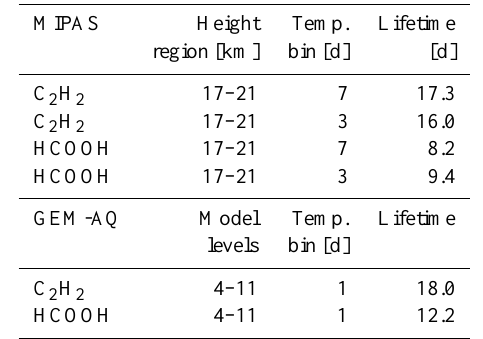
Table 3. Calculated e-folding lifetimes (in days) of measured (MI- PAS) and modelled (GEM-AQ) enhanced C 2 H 2 and HCOOH in the plume released by the Australian bushfires of February 2009. Model levels 4–11 approximately correspond to the height region 17–21km. “Temp. bin” is the length of subsequent periods used for correlation, “d” = days. MIPAS Height